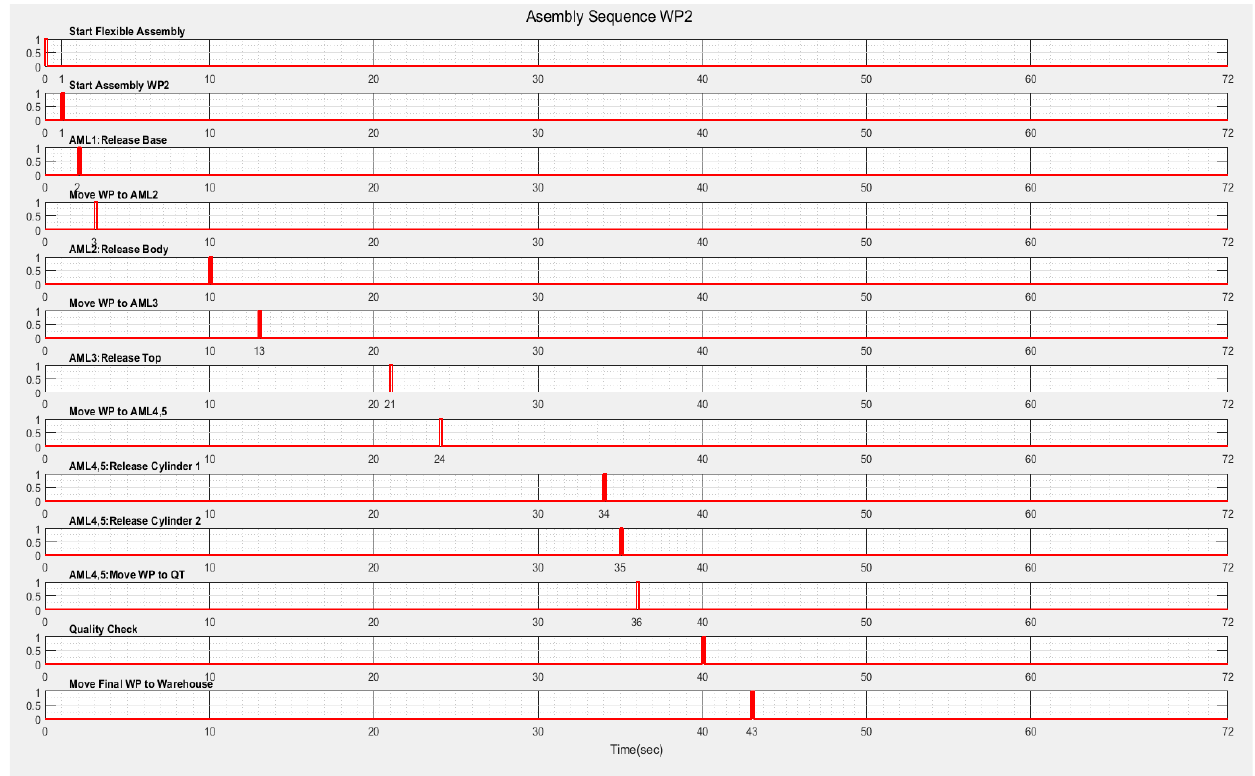
Figure 20. Real-time monitoring signals corresponding to assembly operations of WP2.